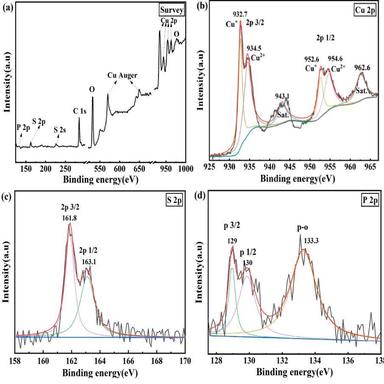
XPS survey spectrum of CuSP (a), and high resolution spectra of Cu 2p (b), S 2p (c), and P 2p (d).